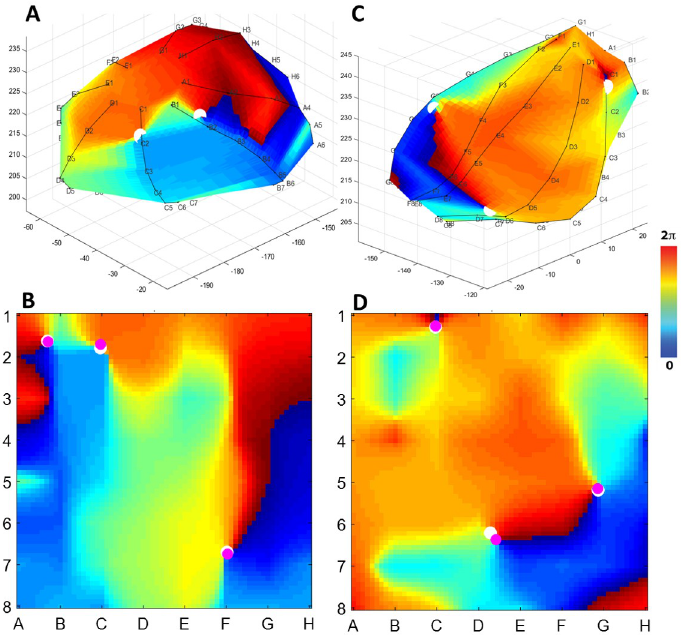
Fig 3. Rotational activation is conserved between 2D and reconstructed 3D shells. (A) Snapshot of a phase map of the left atrium for a 30 year old man using the electrode grid mesh showing two phase singularities (white circles). (B) Phase singularities calculated using the 2D phase map (pink circles) and using the 3D phase map, projected onto the 2D grid. (C) As in (A), and (D) as in (B), showing the right atrium for a 47 year old woman.